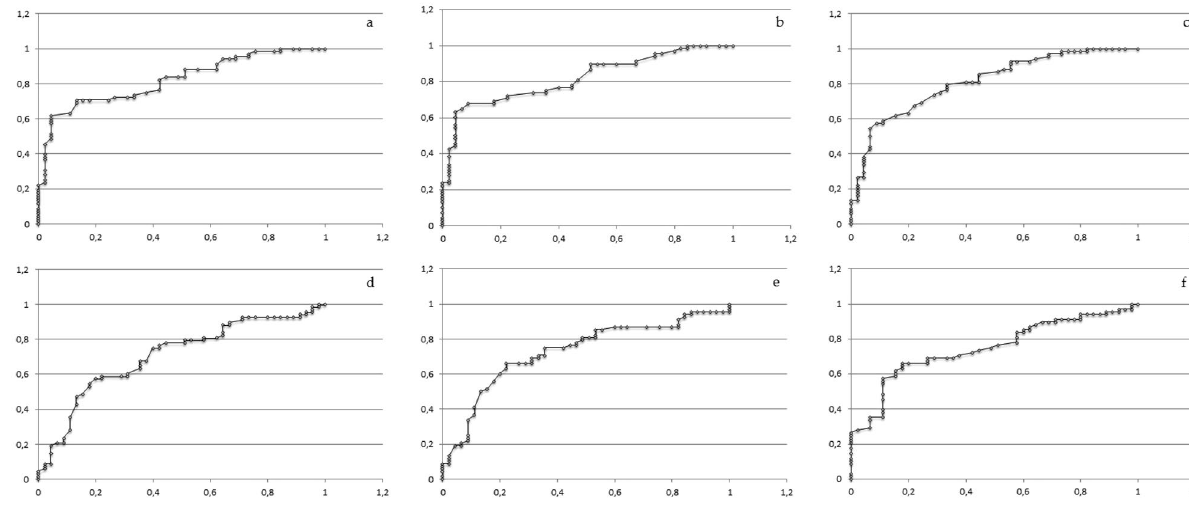
Figure 4. (a–f) The receiver-operating characteristic (ROC) curves for the P300 components. (a) Fz latency. (b) Cz latency. (c) Pz latency. (d) Fz amplitude. (e) Cz amplitude. (f) Pz amplitude. Fz frontal region, Cz central region, Pz parietal region; X axis—specificity; Y axis—sensitivity;